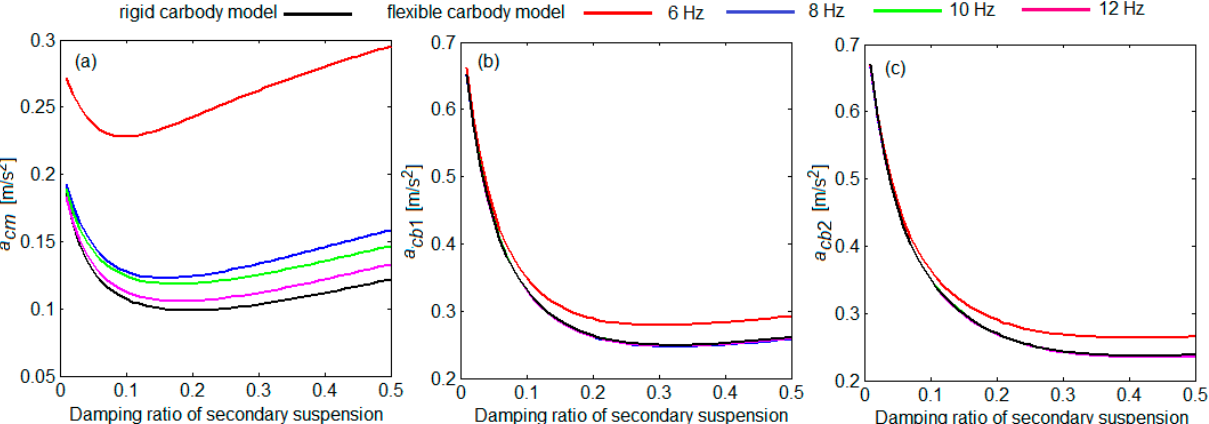
Figure 7. Influence of the carbody vertical bending upon the root mean square of acceleration in correlation with the